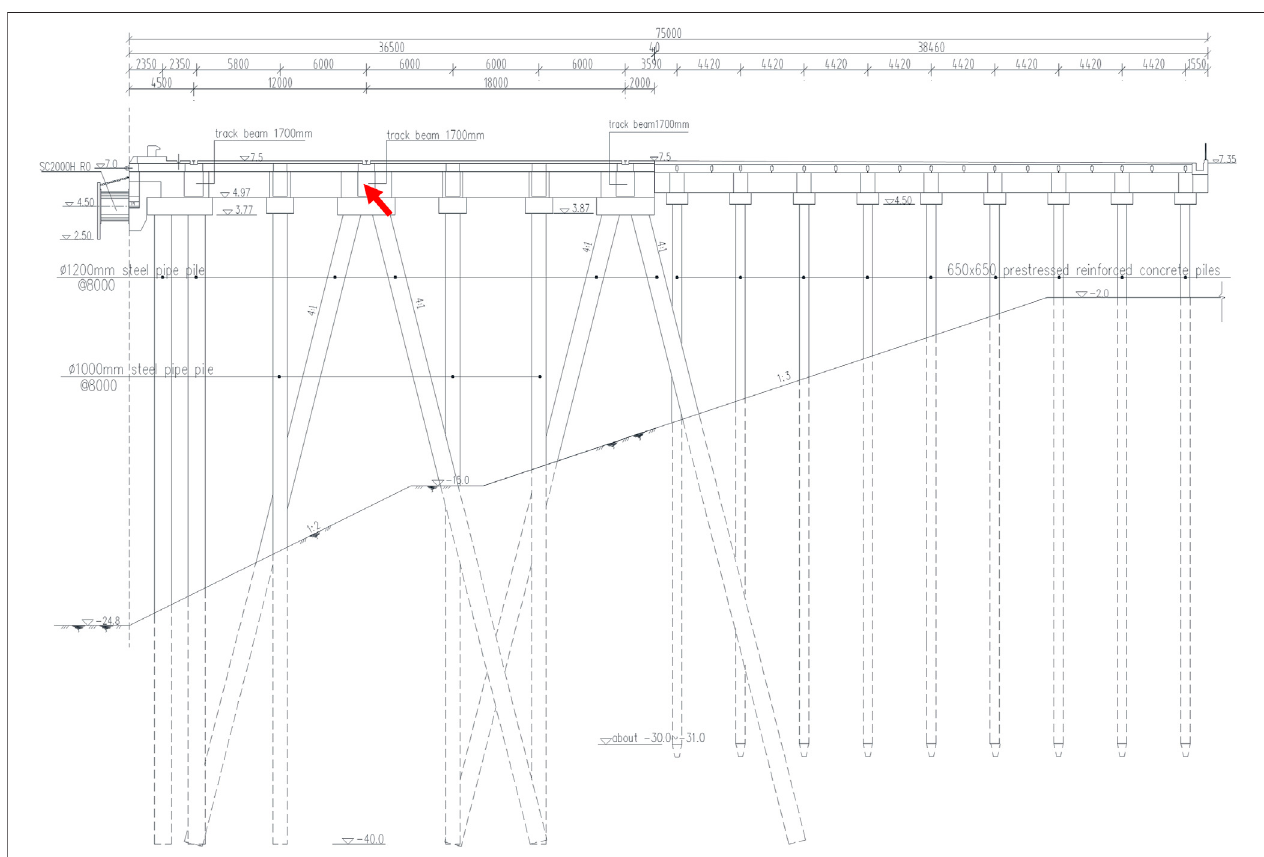
FIGURE 4 | Cross section of the South 27# Wharf.